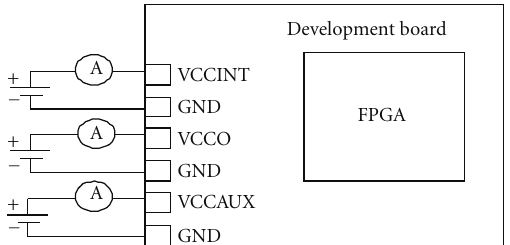
Table 2: Implementation results for Virtex 4 (XC4VFX12) using ISE 9.2.4i with default settings.